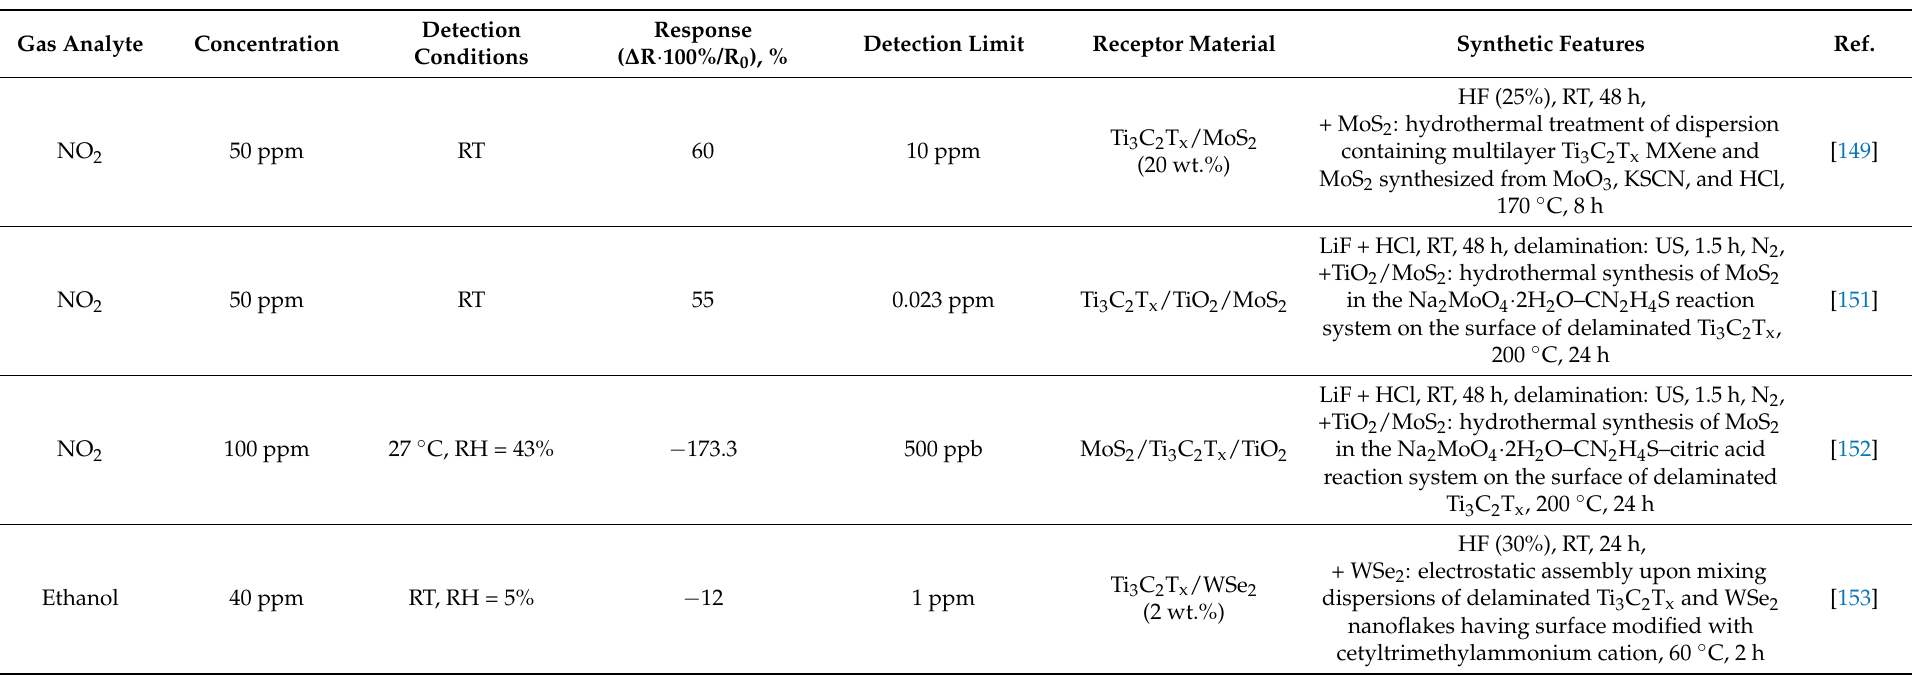
Table 3. Sensory characteristics of nanocomposite coatings containing Ti 3 C 2 T x /Ti 2 CT x MXenes and semiconducting metal chalcogenides (MoS 2 , SnS, WSe 2